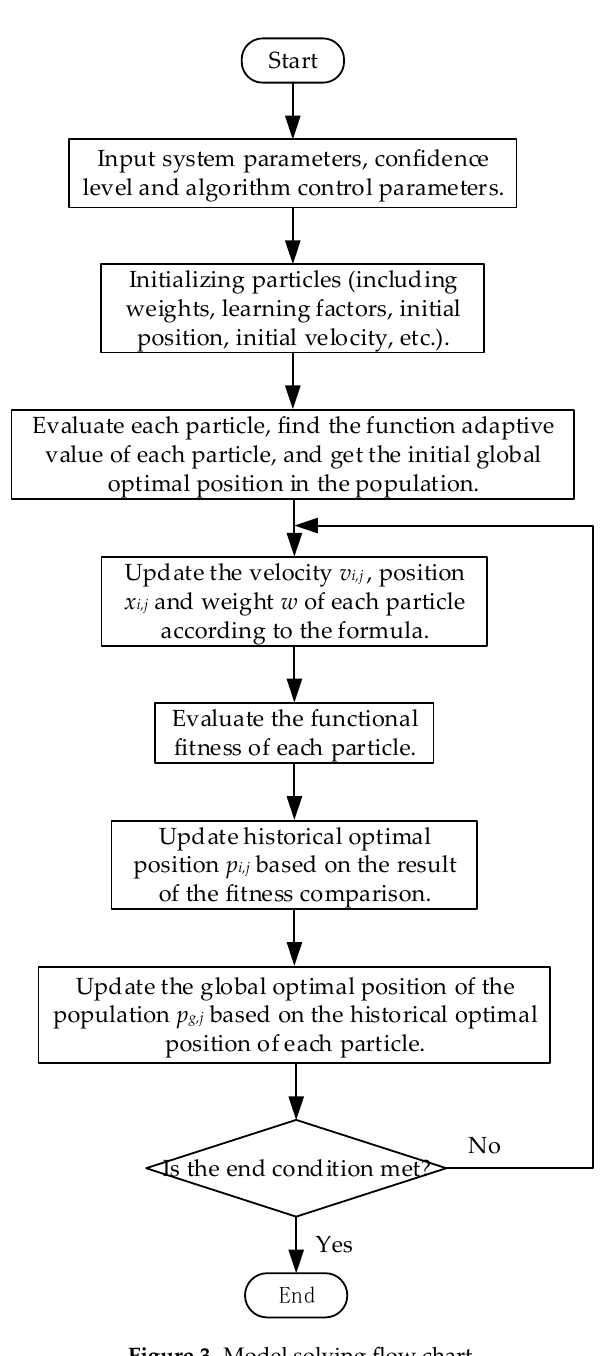
Figure 3. Model solving flow chart. 321